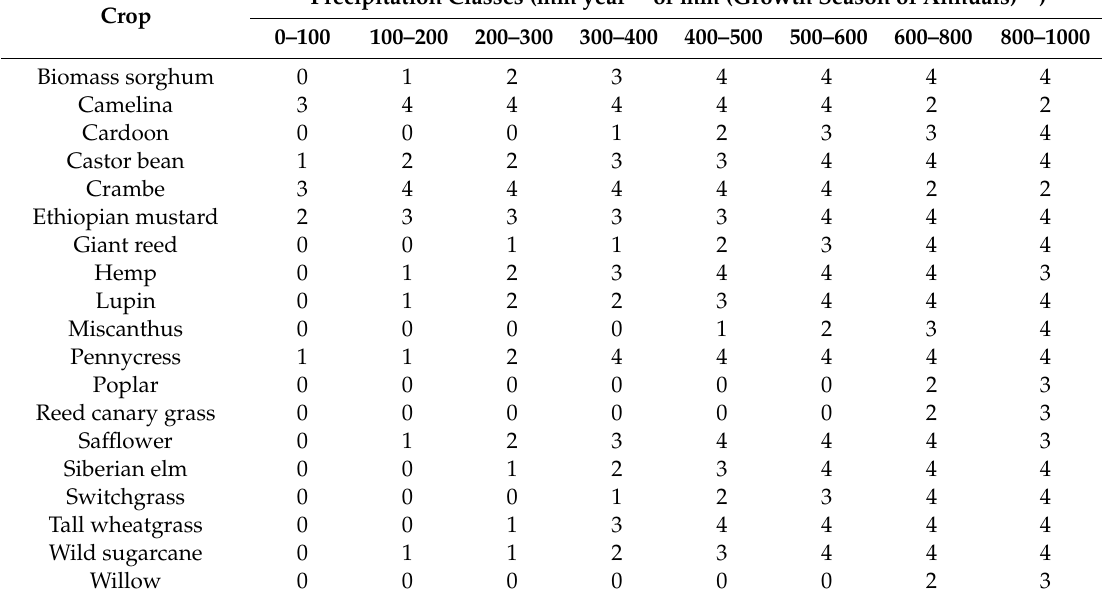
Table A2. Crop-suitability ranking (from 0 = unsuitable to 4 = very suitable, whereas both 0 and 1 were defined as marginal) according to precipitation.